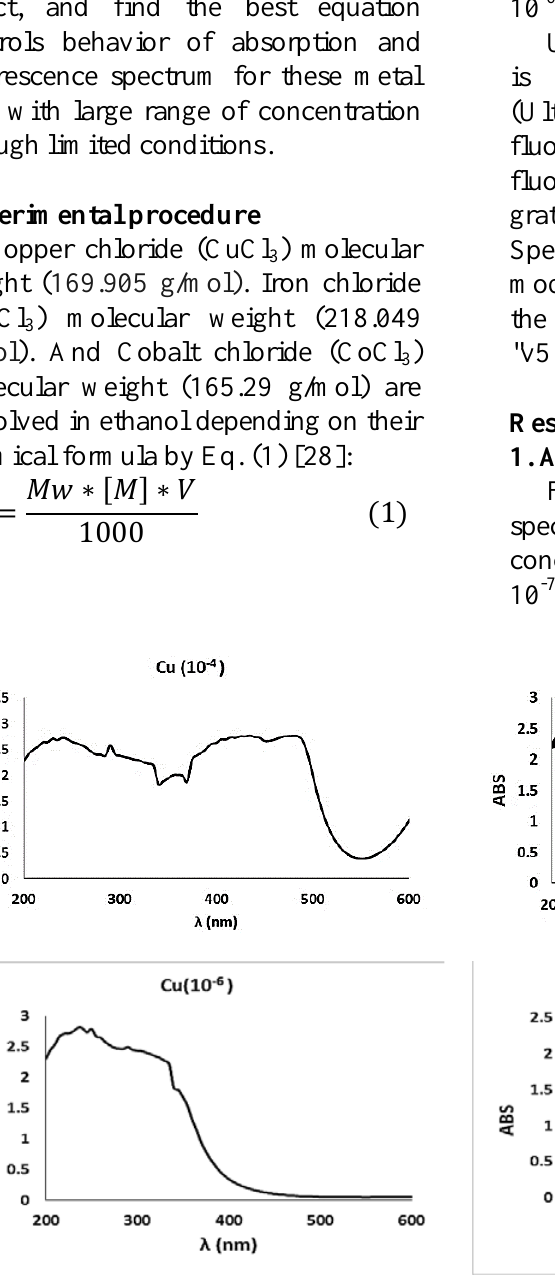
Fig.1: The absorption spectrum of Copper chloride with concentrations of (10 -4 , 10 -5 , 10 -6 , 10 -7 ) gm/m 3